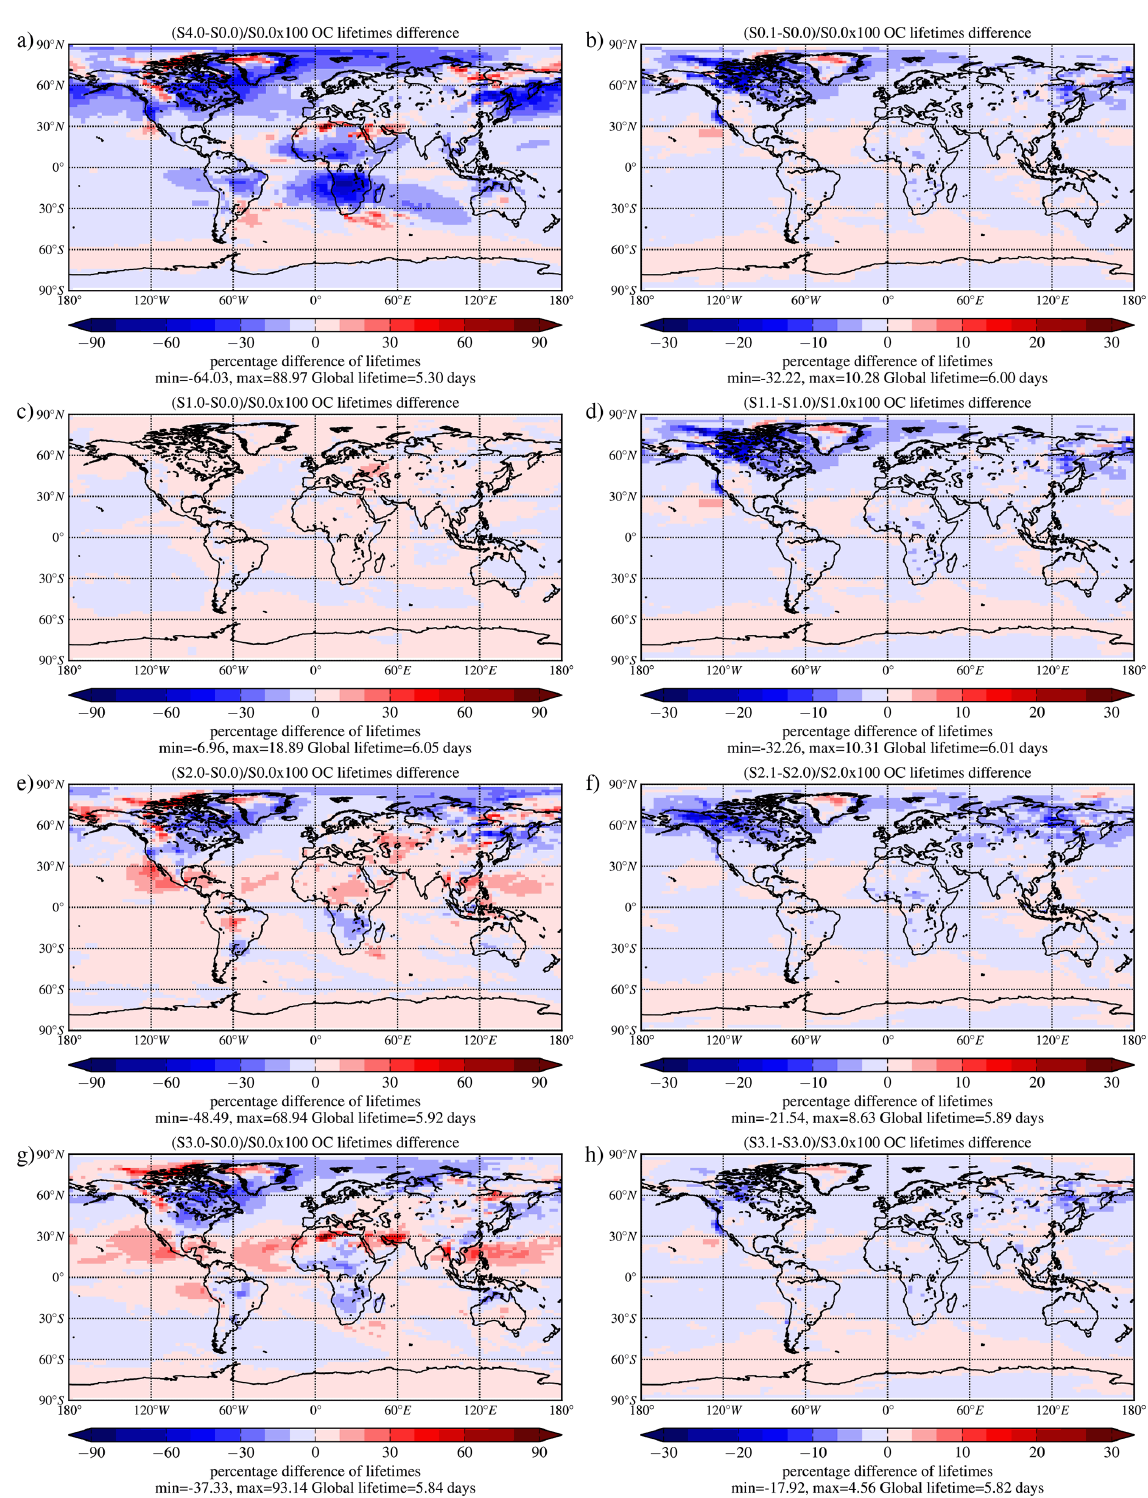
Figure 9. Percentage of impact on the computed annual mean tropospheric lifetime of OC of (left panels) the different emission inventories calculated as the percentage difference between simulations SX.0 and simulation S0.0, and of (right panels) height distribution calculated as the percentage difference between simulations SX.1 and simulations SX.0. The color bar ranges from − 90 to 90% for the surface differences and − 30 to 30% for the differences induced by height distribution. The minimum and maximum local lifetime percentage changes as well as the global lifetime are printed below each